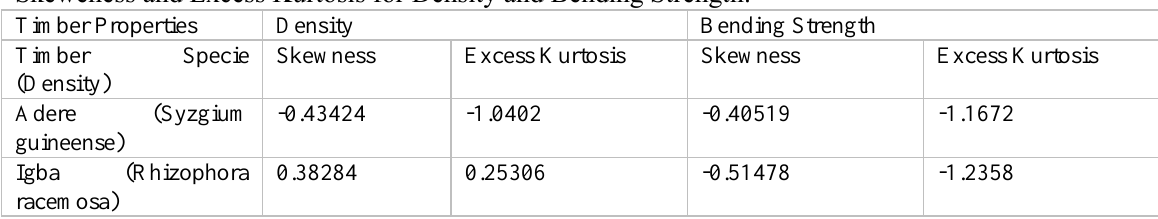
Skeweness and Excess Kurtosis for Density and Bending Strength.